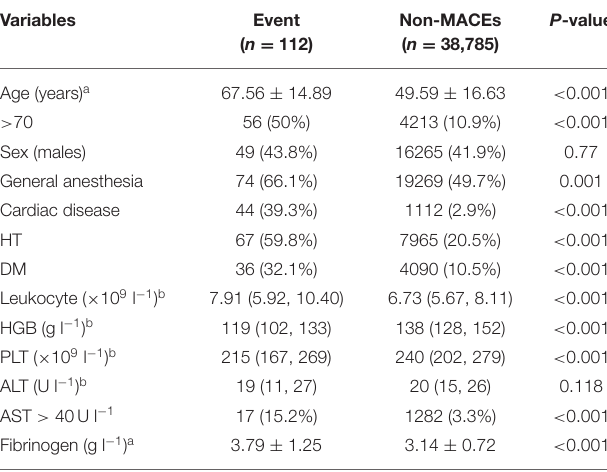
TABLE 6 | Baseline Characteristics of the validation set.